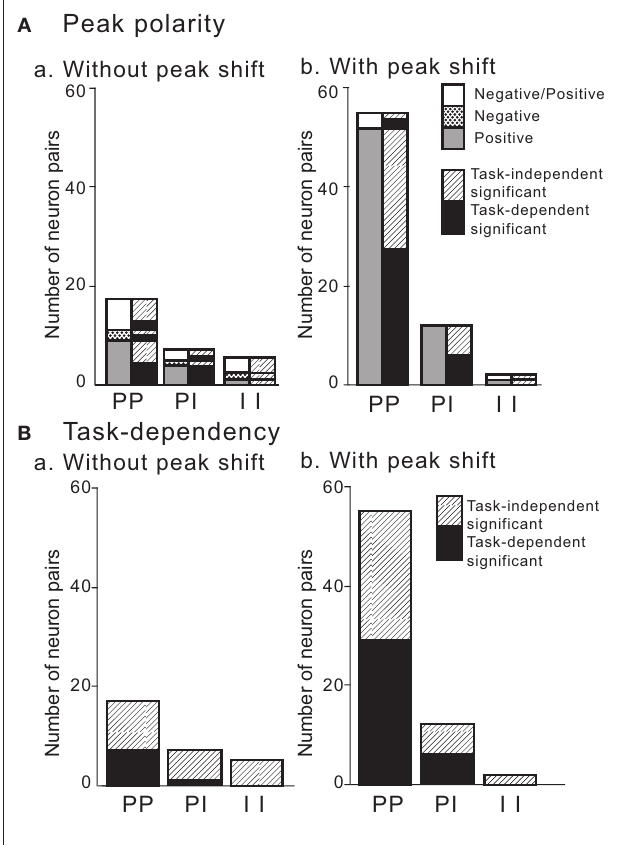
Figure 14 | Polarity (A) and task-dependency (B) of the CCg peaks without or with a peak shift in terms of the types of the neuron pairs. To facilitate comparison of the data between (A) (peak polarity) and (B) (task-dependency), corresponding task-dependency is shown in the right column of each type of neuron pair in (A) . Note that most pairs with a peak shift had positive peaks. Positive, positive peaks; Negative, negative peaks; Negative/Positive, center-negative and surround-positive peaks. PP, pyramidal neuron vs. pyramidal neuron; PI, pyramidal neuron vs. interneuron; II, interneuron vs. interneuron. Task-independent significant, task-independent significant CCG peaks; task-dependent significant, task-dependent significant CCG